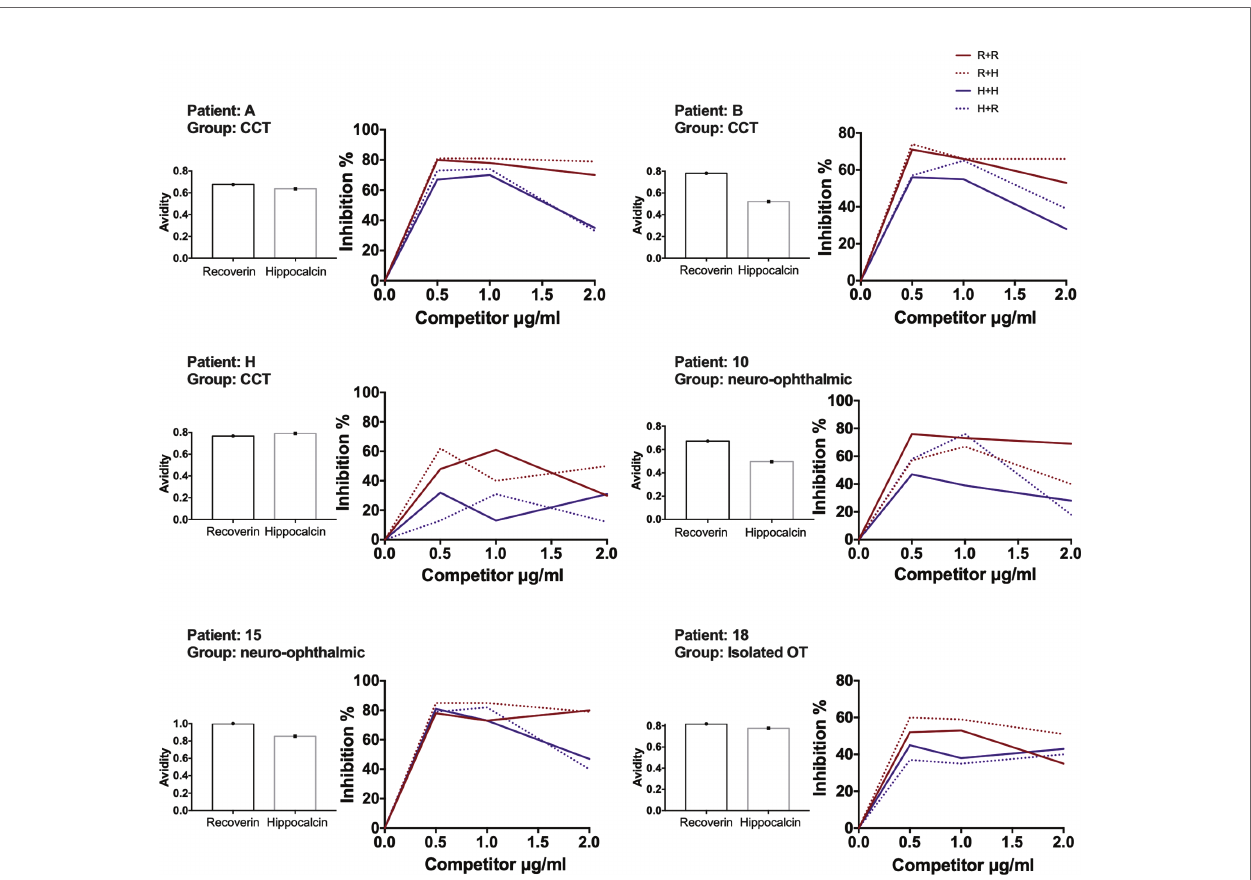
FIGURE 9 | Recoverin-hippocalcin inhibition assay. For each patient the avidity to recoverin and hippocalcin is shown on the left side, the percent inhibition is plotted on the right side according to the added concentration of the competing antigen under four different conditions: – R + R plate coated with recoverin + serum treated with recoverin; - - - R + H plate coated with recoverin + serum treated with hippocalcin; – H + H plate coated with hippocalcin + serum treated with hippocalcin, - - - H + R plate coated with hippocalcin + serum treated with